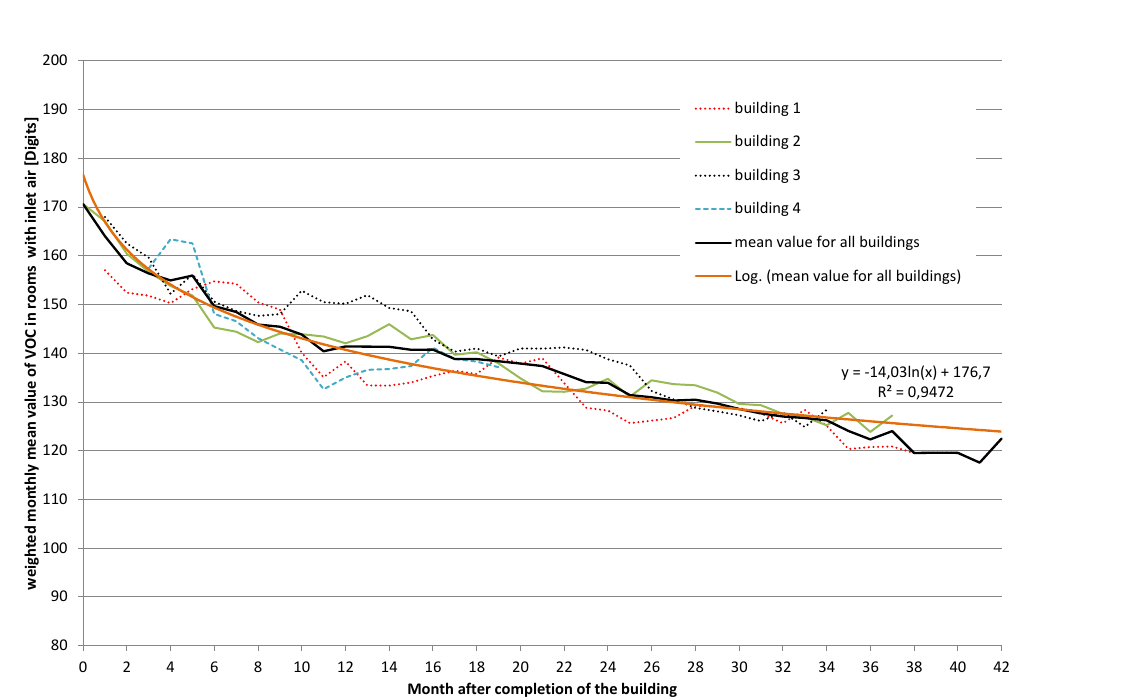
Figure 12. Weighted mean VOC concentration in the four test buildings in time elapsed after